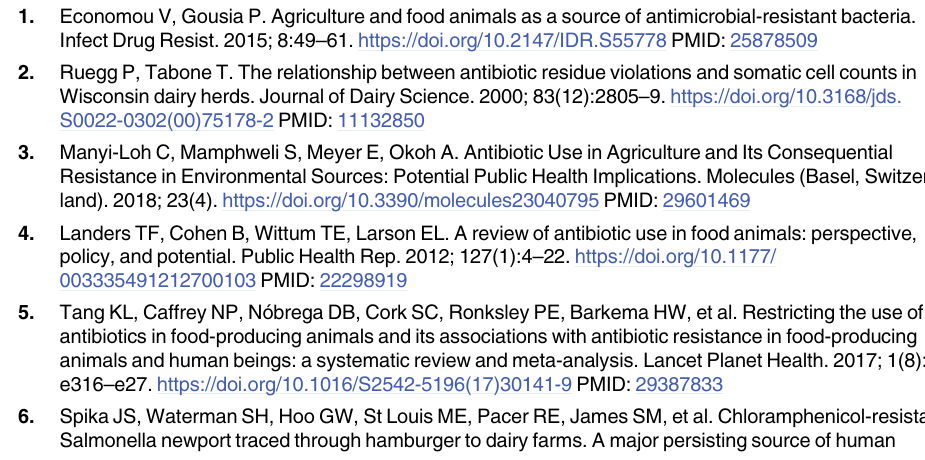
S1 Fig. Questionnaire guide. The questionnaire guide developed to conduct the semi-structed focus group interviews. S2 Fig. Checklist. Checklist used to conduct direct observations on farms. S1 File. Focus group full transcripts. Full dataset used for